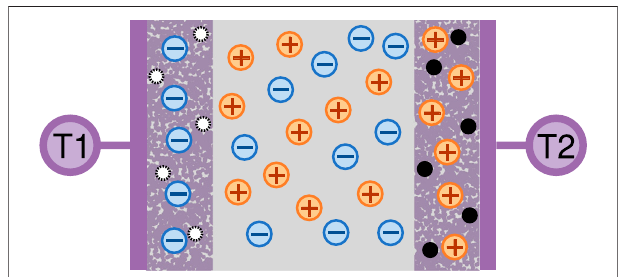
FIGURE 7 | The structure of a traditional electronic supercapacitor. Shown in a charged state with electrical terminal T1 at higher voltage and terminal T2 at lower